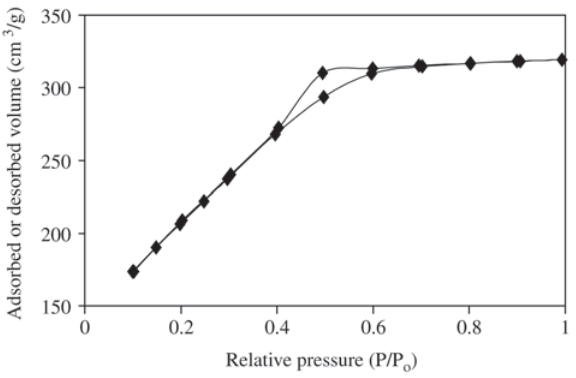
Figure 1. Isotherm of N adsorption-desorption obtained for the 2 porous silica via conventional